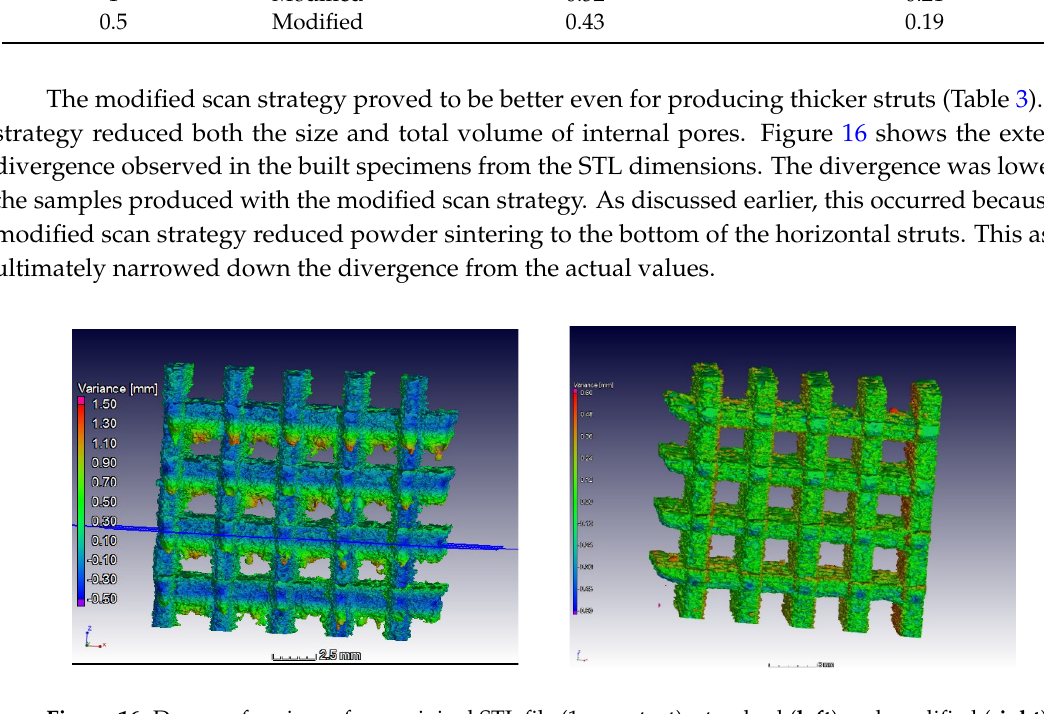
Figure 16. Degree of variance from original STL file (1 mm strut): standard ( left ) and modified ( right ) scan strategies.